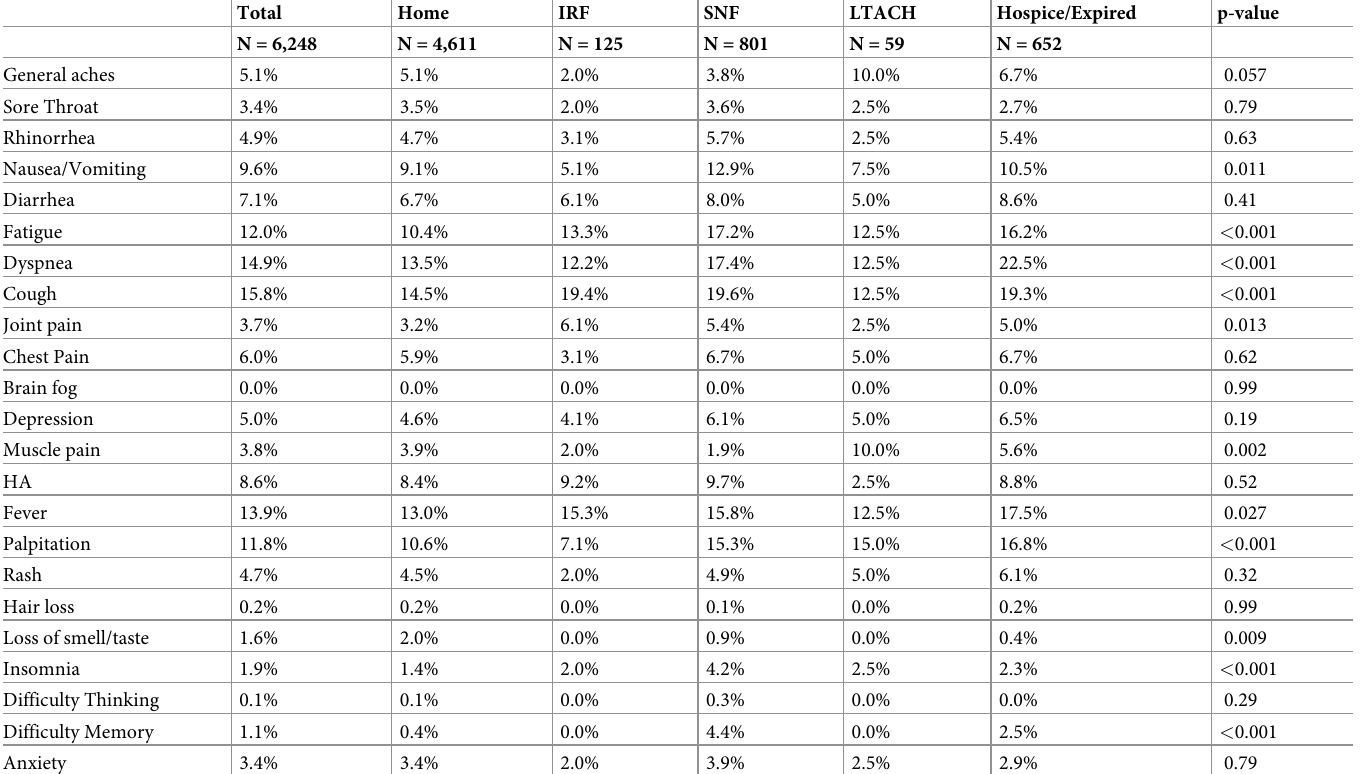
Table 5. Analysis of discharge disposition based on symptom at presentation. Categorical variables expressed as